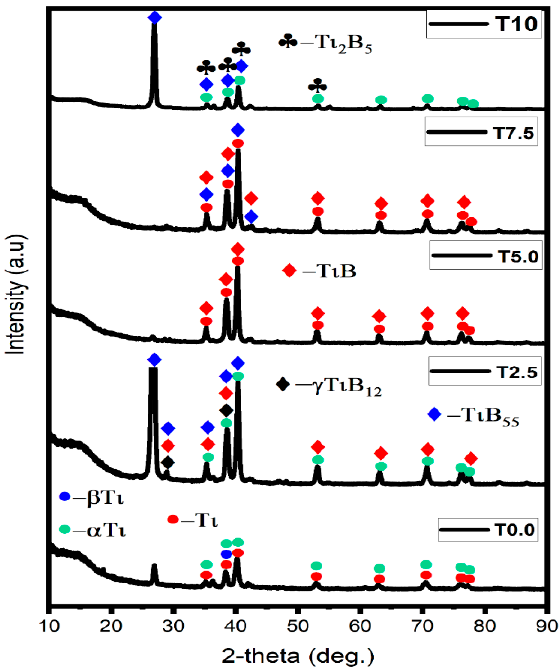
Materials 2023 , 16 , x FOR PEER REVIEW Figure 3. The diffractogram of the consolidated Ti and TiB 2 – Ti composites. Figure 3. The diffractogram of the consolidated Ti and TiB